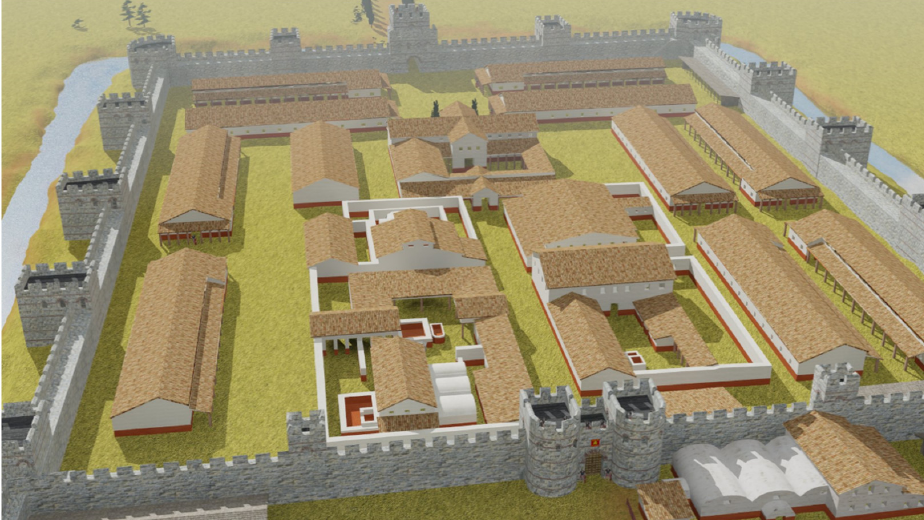
Figure 10. General view of the castellum from the eastern gate.